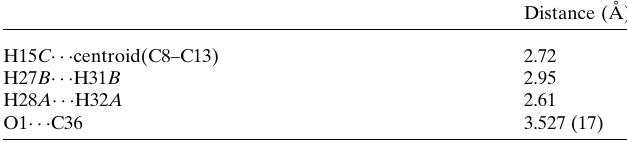
Table 1 Intermolecular distances in the unit cell of (MesNHC 2 Me)Ni(COD). Standard deviations for distances including H atoms are omitted because H atoms were positionally fixed.